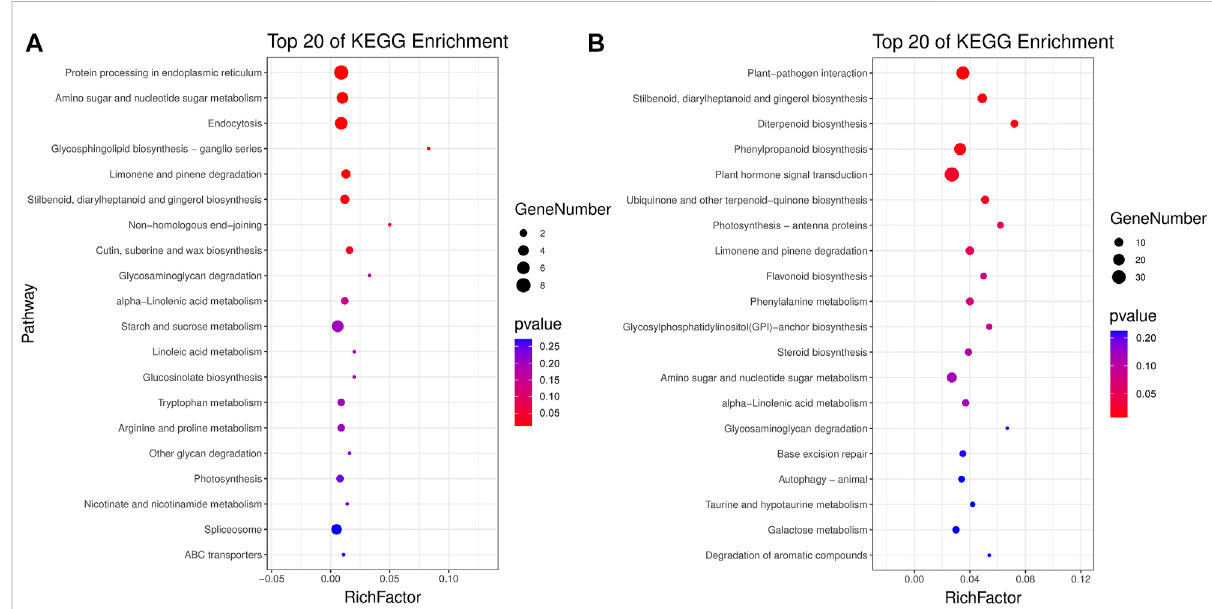
FIGURE 5 KEGG pathway enrichment. Top 20 KEGG pathways enriched by DMGs identi fi ed in sequence contexts of CG (A) and CHH (B) in winter rapeseed 17NS under freezing